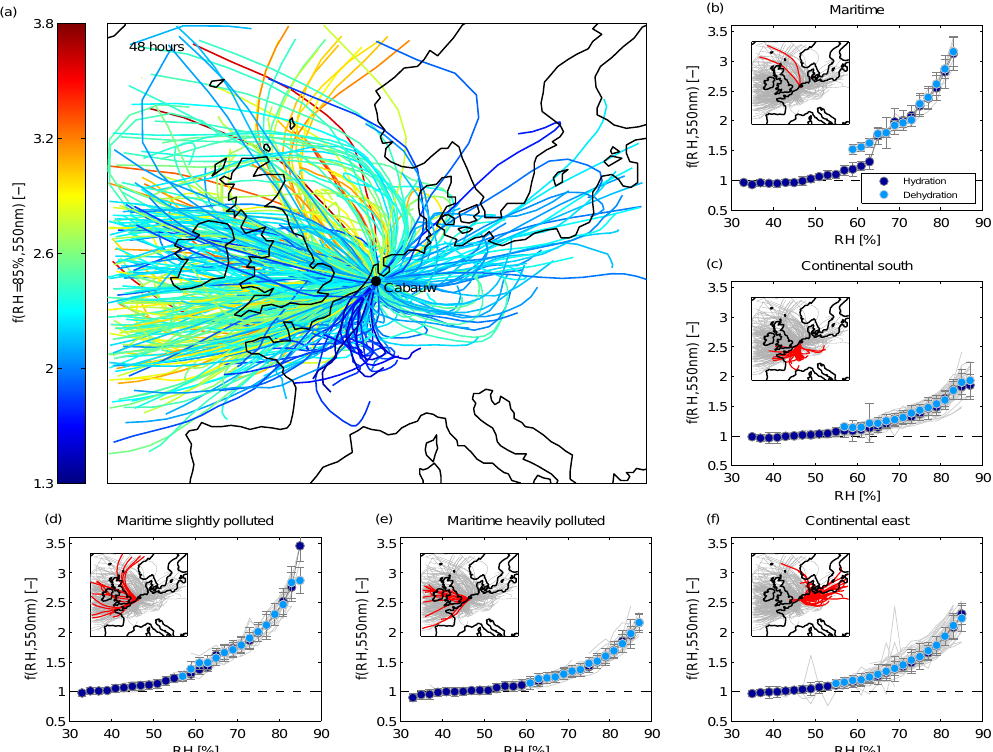
Fig. 2. Panel (a) FLEXTRA trajectories (48h backward calculation) of air parcels arriving at Cabauw. The trajectories are color coded with the mean aerosol scattering enhancement f (RH=85%, 550nm) measured at the site. Panels (b) – (f) Example humidograms classified by the origin of the air masses. Dark blue circles denote averages of f (RH) for the hydration branch of the humidogram, while light blue circles are averages of the dehydration branch (2% RH bins). Underlined in grey are the individual humidograms of each trajectory. Error bars denote the standard